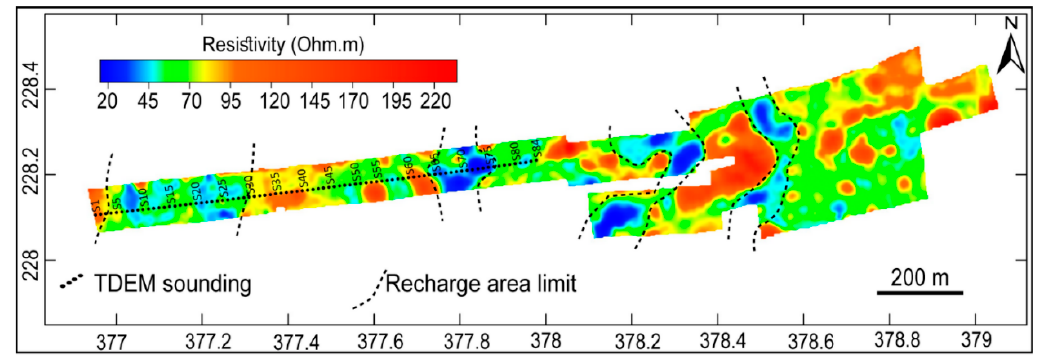
Figure 7. Apparent resistivity map obtained from EM31 data.